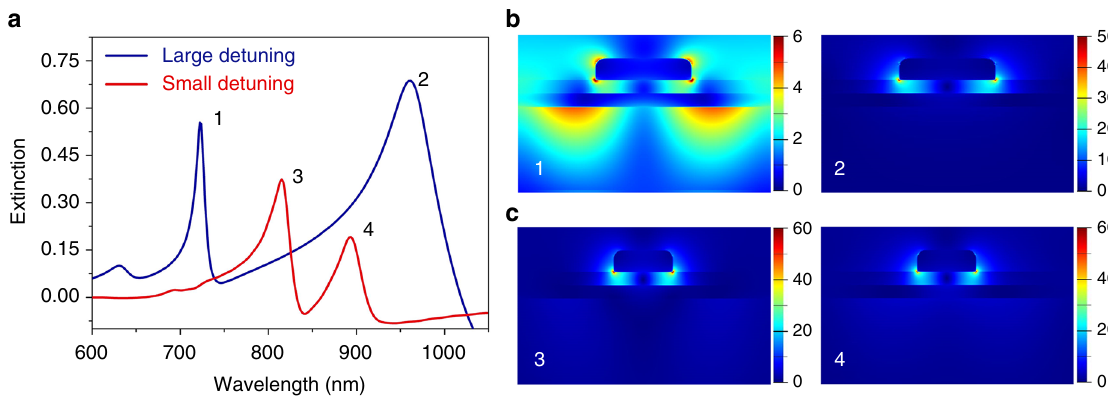
Fig. 3 Simulated spectra and electric fi eld distributions. a Simulated extinction spectra with large (~396 meV) and small detuning (~19 meV). For the large detuning, the nanoblock size is 150 nm, and the period is 400 nm. For the small detuning, the nanoblock size is 115 nm, and the period is 500 nm. b , c Electric fi eld (| E |) distributions are simulated at 1 – 4 resonance wavelengths labeled on the extinction